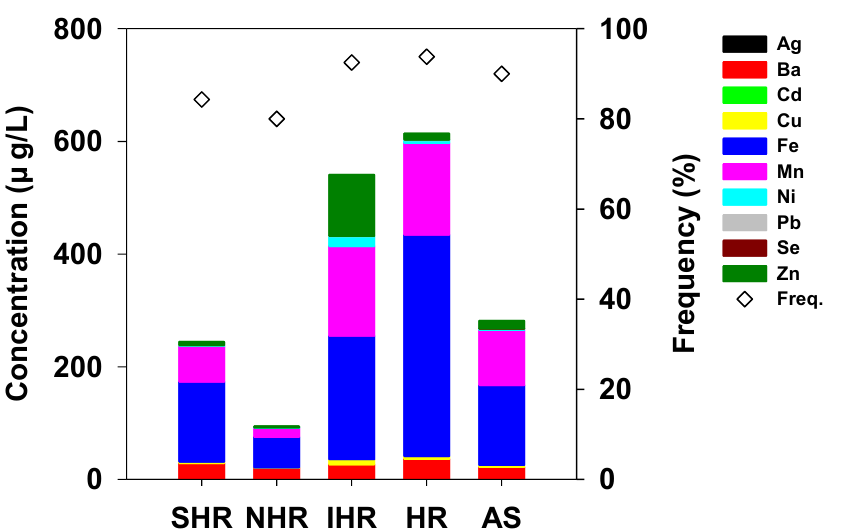
Figure 2. Cumulative concentration and detection frequency at five areas in the Han River watershed.